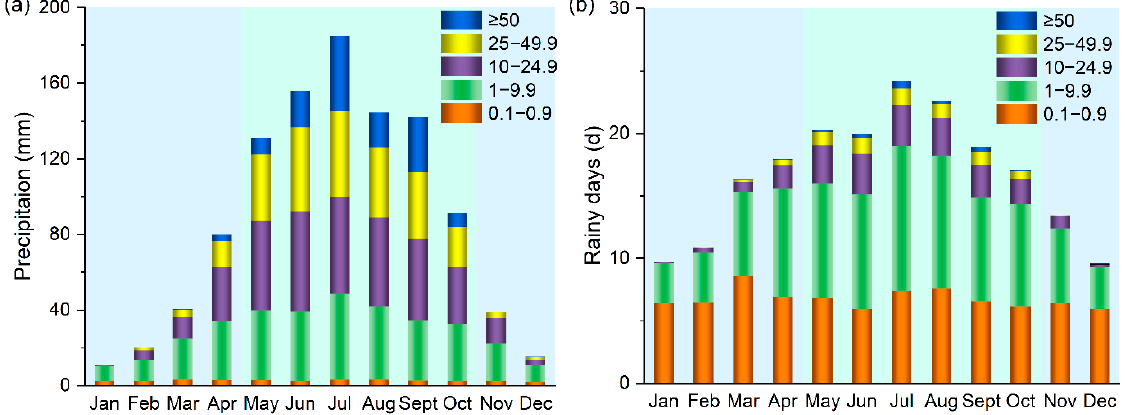
Figure 3. Monthly ( a ) precipitation and ( b ) rainy days at the five intensity levels in the Daning River basin.